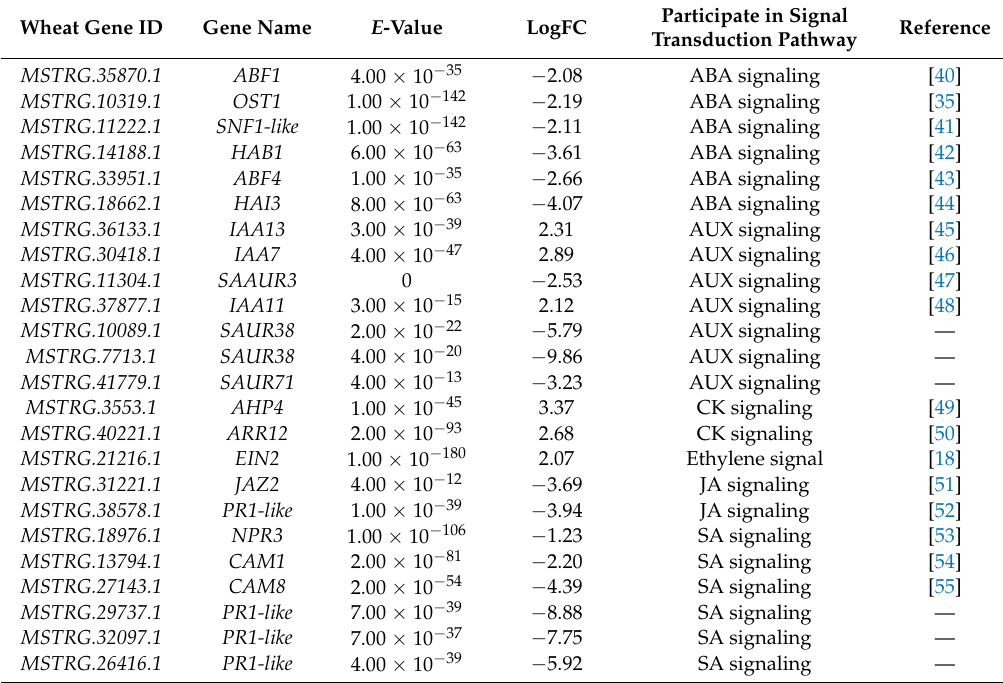
Table 3. Plant hormone-related DEGs.